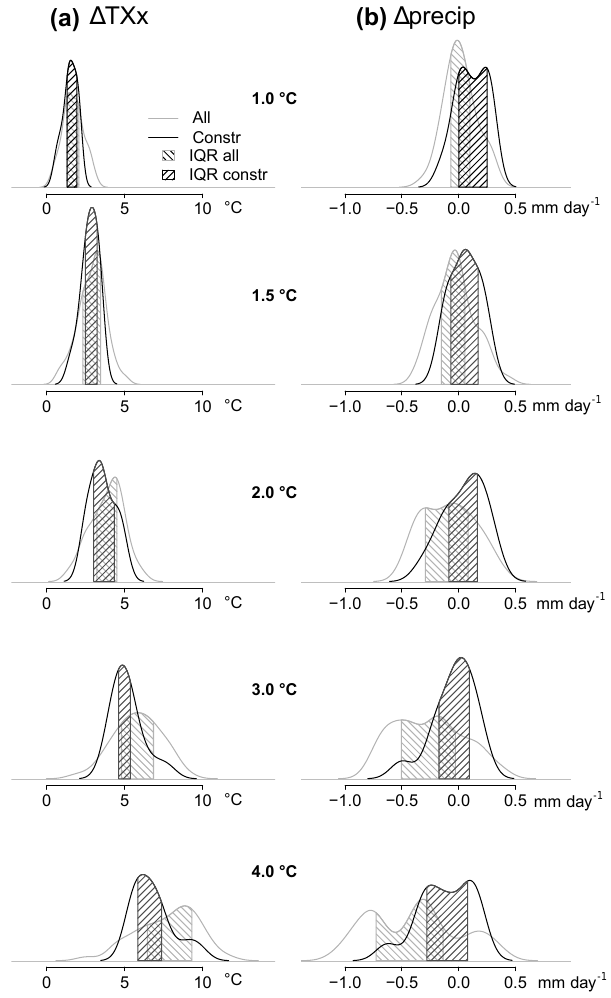
Figure 8. Distribution of TXx (a) and precipitation (b) changes according to global warming levels of 1, 1.5, 2, 3 and 4 ◦ C for the full (grey) and the constrained ensemble (black). The shaded area represents the interquartile range (IQR) of the two